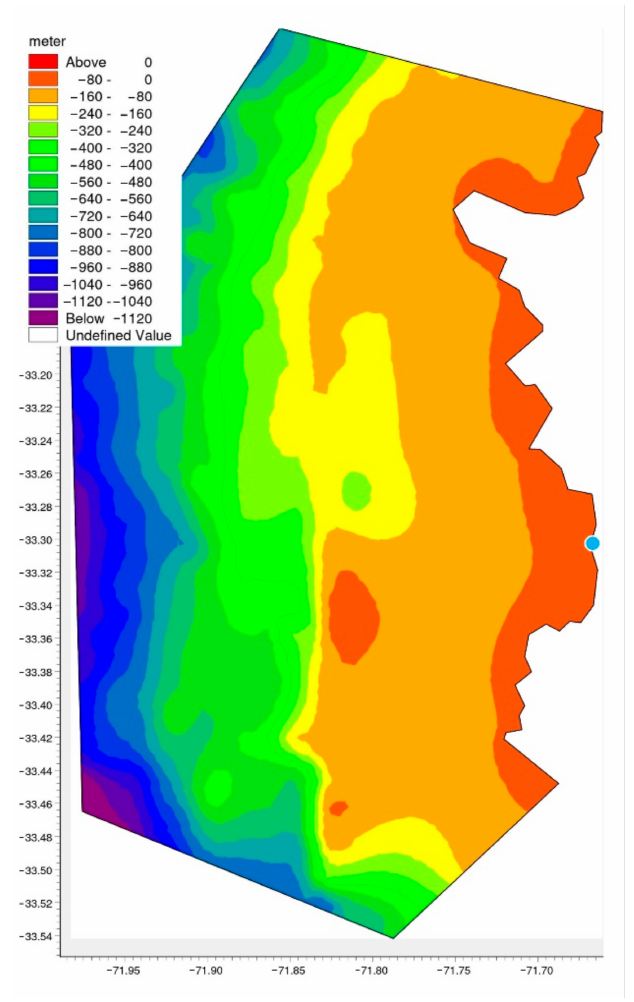
Figure 3. Bathymetry of the study area. The blue circle represents the point S, where nearshore wave data are